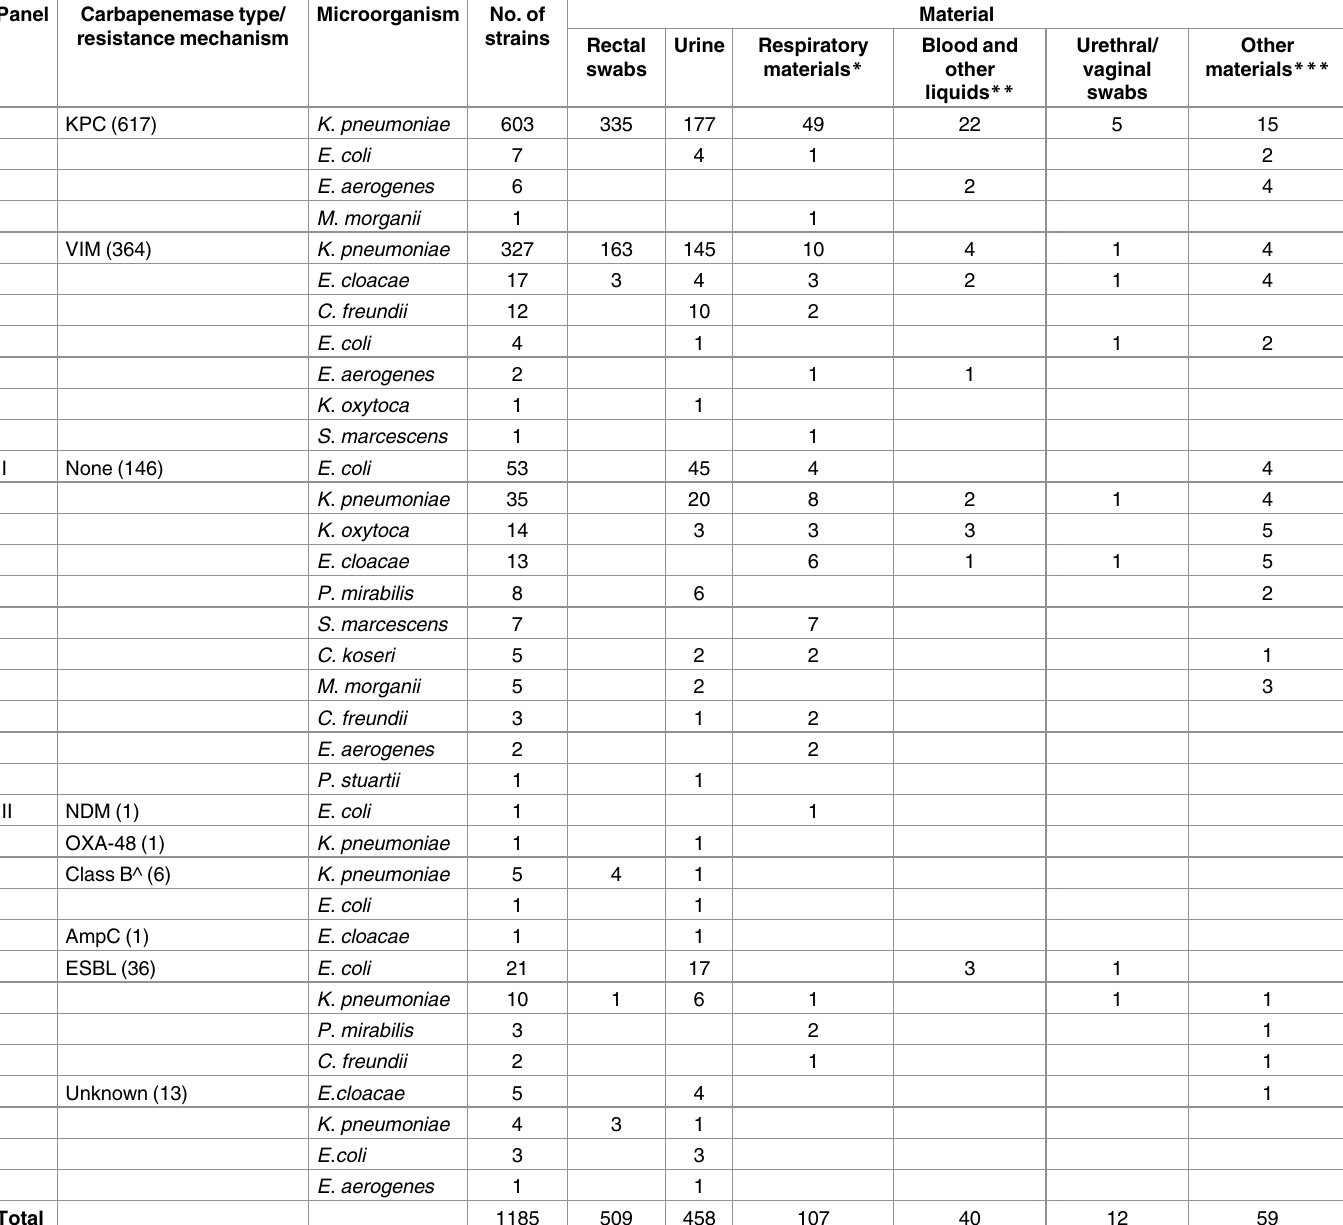
Table 1. Clinical carbapenemase-producing and -nonproducing Enterobacteriaceae strains analysed in this study.